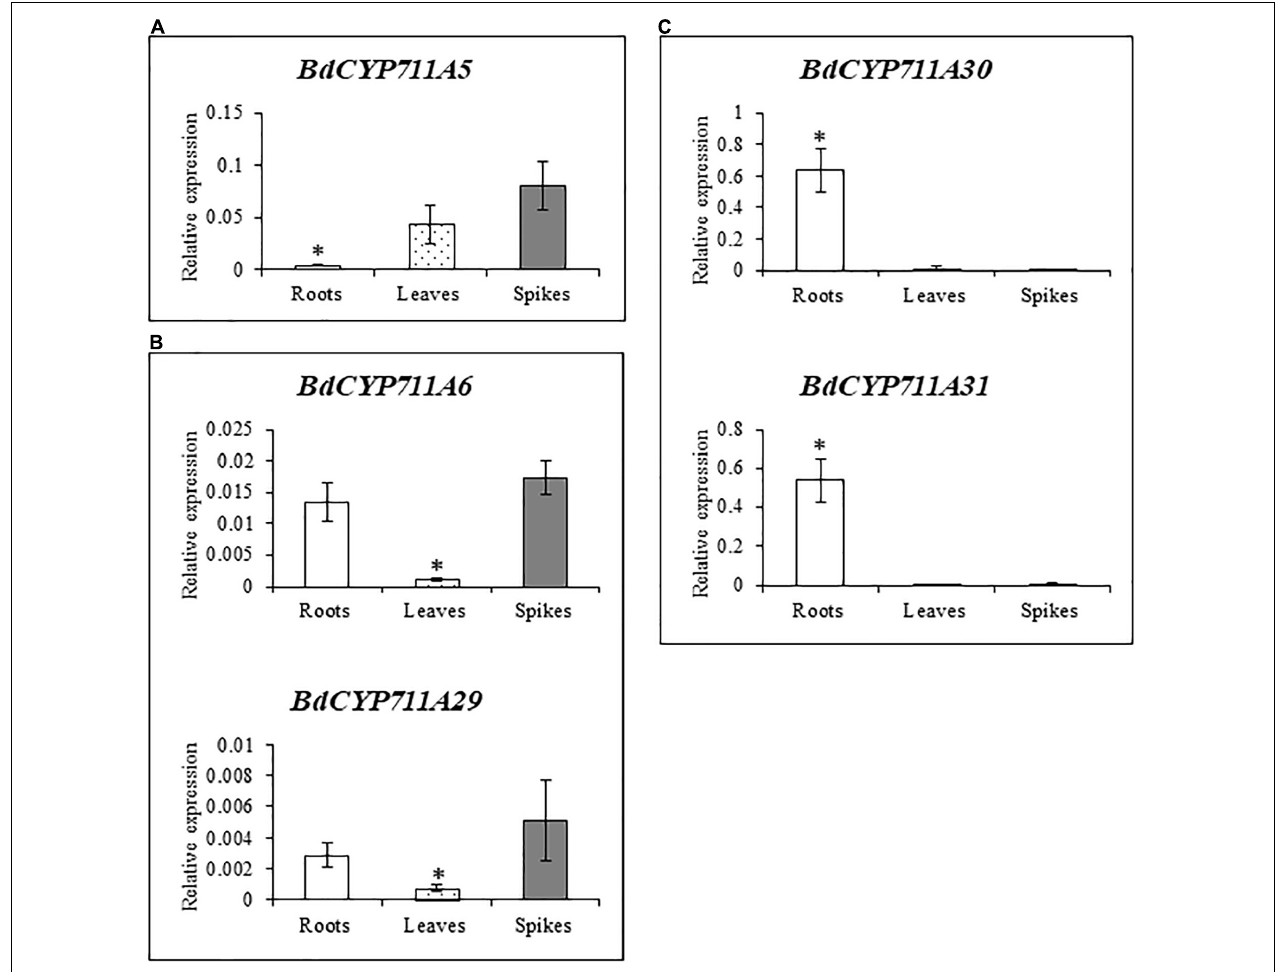
FIGURE 3 | Expression pattern of the 5 BdCYP711A genes in roots, leaves, and spikes. (A) , (B) , and (C) correspond to different expression patterns, mentioned as categories in the main text. Relative quantification of transcripts of the BdCYP711A5 ( Bradi3g08360 ), BdCYP711A6 ( Bradi1g37730 ), BdCYP711A29 ( Bradi1g75310 ), BdCYP711A30 ( Bradi4g08970 ), and BdCYP711A31 ( Bradi4g09040 ) genes in different organs of the Bd21-3 (WT) ecotype of B. distachyon : roots and leaves were collected from 3 week-old plants under hydroponic conditions in 1 / 2 MS liquid medium and spikes were collected at mid-anthesis on plants grown in pots under standard conditions. The relative quantity of transcripts was calculated using the comparative cycle threshold (Ct) method (2 - (cid:49) Ct ) using the B. distachyon UBC18 and ACT7 genes ( Bradi4g00660 and Bradi4g41850 ) as endogenous controls to normalize the data for differences in input RNA between the different samples. Mean of three independent biological replicates ± standard deviation. For each gene, asterisks indicate significant differences between organs (* p value < 0.05, Student’s t- test).